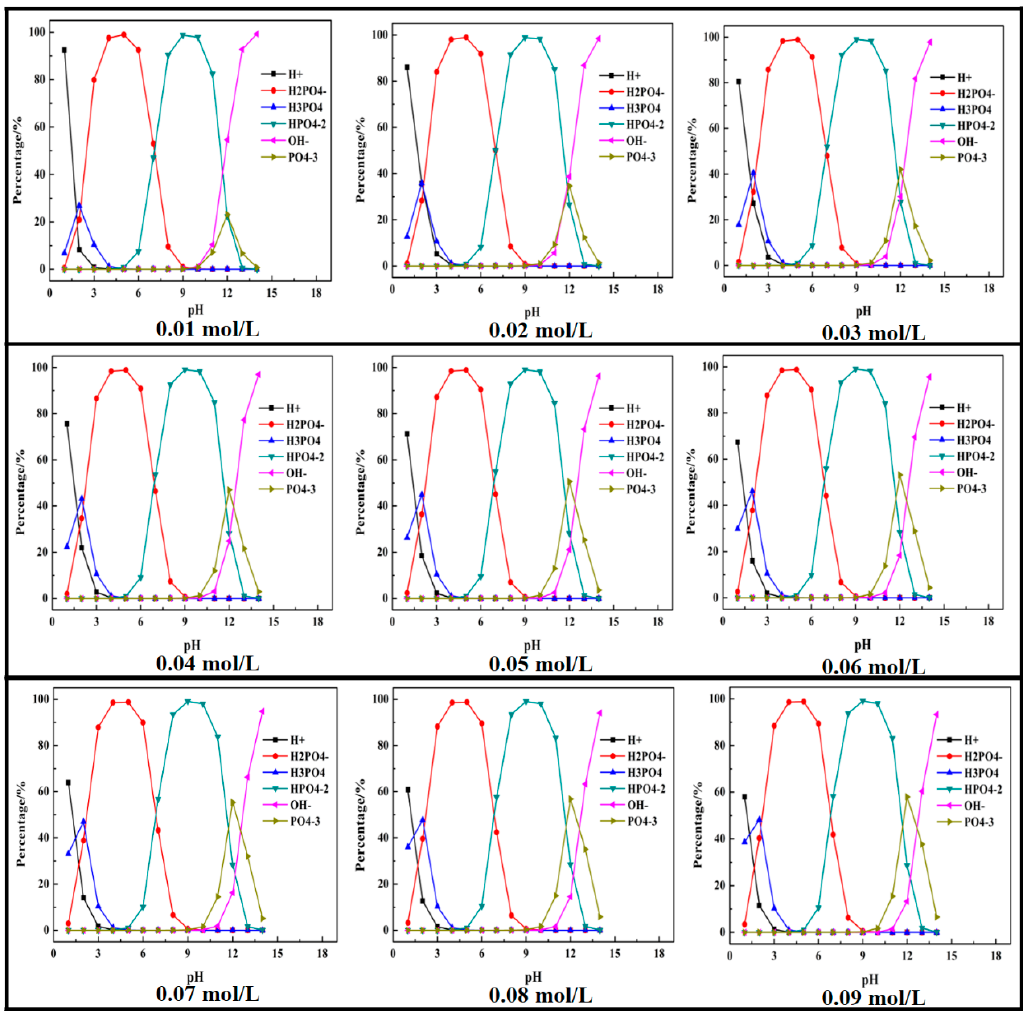
Figure 1. Mole fraction diagram of phosphorus species in the P-H 2 O system at 298 K at various pH ((P) = 0.01 to 0.90 mol/L).